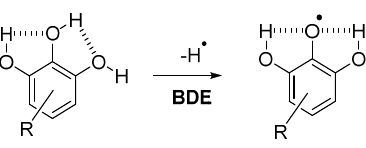
Table 4. BDEs comparison between pyrogallol ( 15 , 1 , 2 , 32 and 55 ) and catechol ( 16 , 6 , 63 , 34